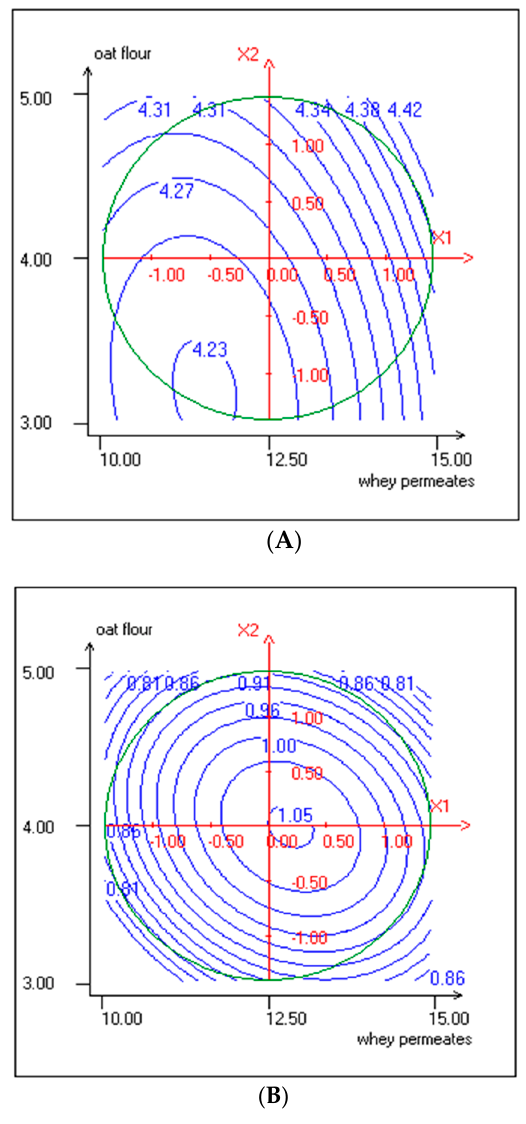
Figure 2. ( A ) Response surface and contour plots representing the effect of WP and OF on pH values (X1: WP; X2: OF). ( B ) Response surface and contour plots representing the effect of WP and OF on TTA (X1: WP; X2: OF).